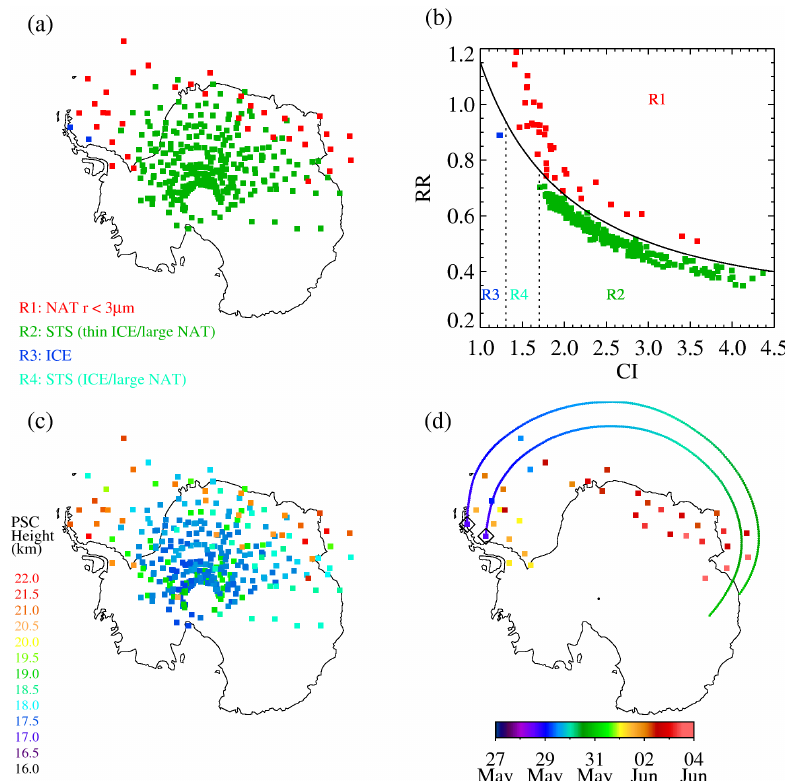
Fig. 11. Geographic distribution and spectral color-ratios of PSCs detected by MIPAS from 28 May–3 June 2008. (a) MIPAS PSC type classification (CI < 4 . 5, for all types R1–4) at the altitudes corresponding to the maximum cloud opacity (minimum CI) detected above the tropopause. (b) The distribution of color-ratios corresponding to (a) . The region R1 contains NAT clouds (red square symbols) with mean particle radii < 3µm and well-defined NAT spectral signatures. R1 is separated from the other regions (R2–4) by a functional form (solid black curve) given by H¨opfner et al. (2006b). Dashed lines show the regions most likely to contain ICE (R3 (blue), CI < 1 . 3) and STS (R4 (cyan), 1 . 7 < CI < 1 . 3). For the data in regions R2 (green) and R4, MIPAS is unable to distinguish between STS or large NAT with mean particle radii > 3µm. (c) PSC altitudes corresponding to maximum cloud opacity for the data in (a) and color-coded according to the scale at the left. (d) MIPAS PSC type classification for solid types only (R1 and R3). Forward trajectories on the 500K potential temperature surface were launched from the locations shown by the diamond symbols at the times when PSCs classified as ice types were detected. The color scale in (d) indicates the PSC observation times and the time along the trajectories, such that trajectories passing near or intersecting with observations at near coincident times have similar